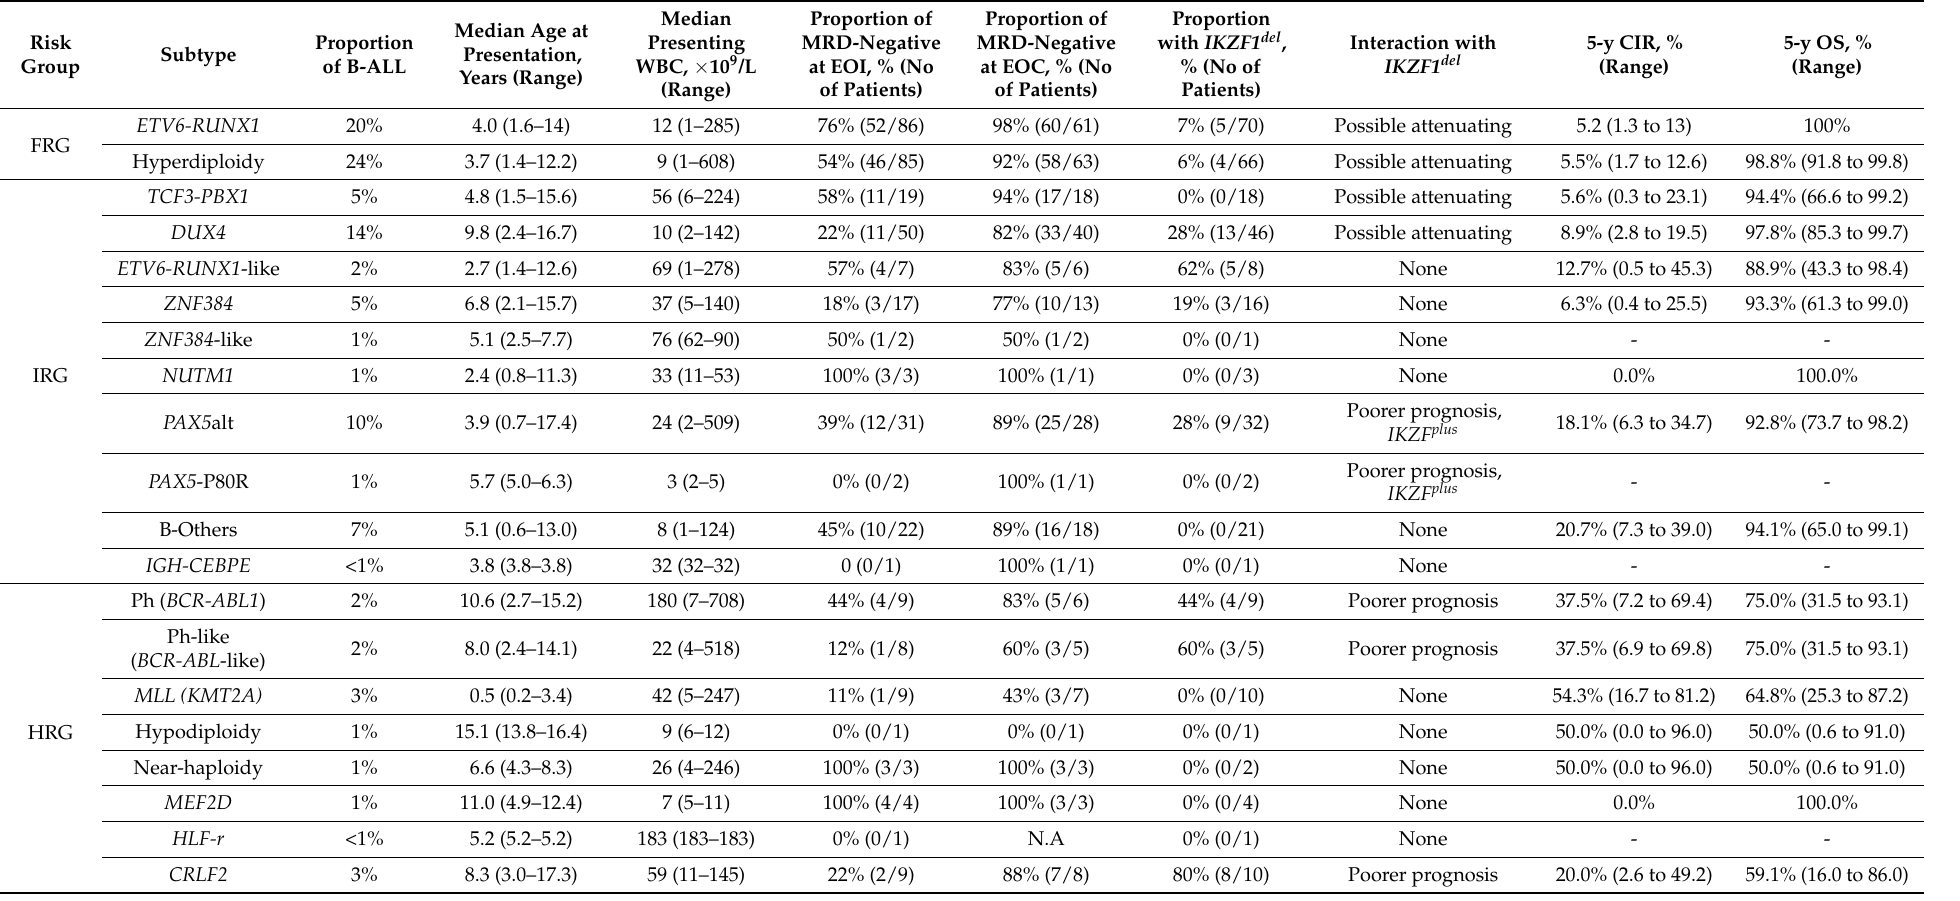
Table 1. Overview of B-ALL subtypes and summary of clinical characteristics of individual subtypes based on Malaysia-Singapore 2003 and 2010